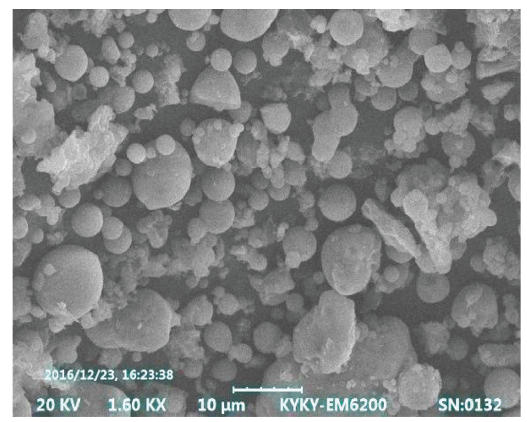
Figure 5: Fly ash